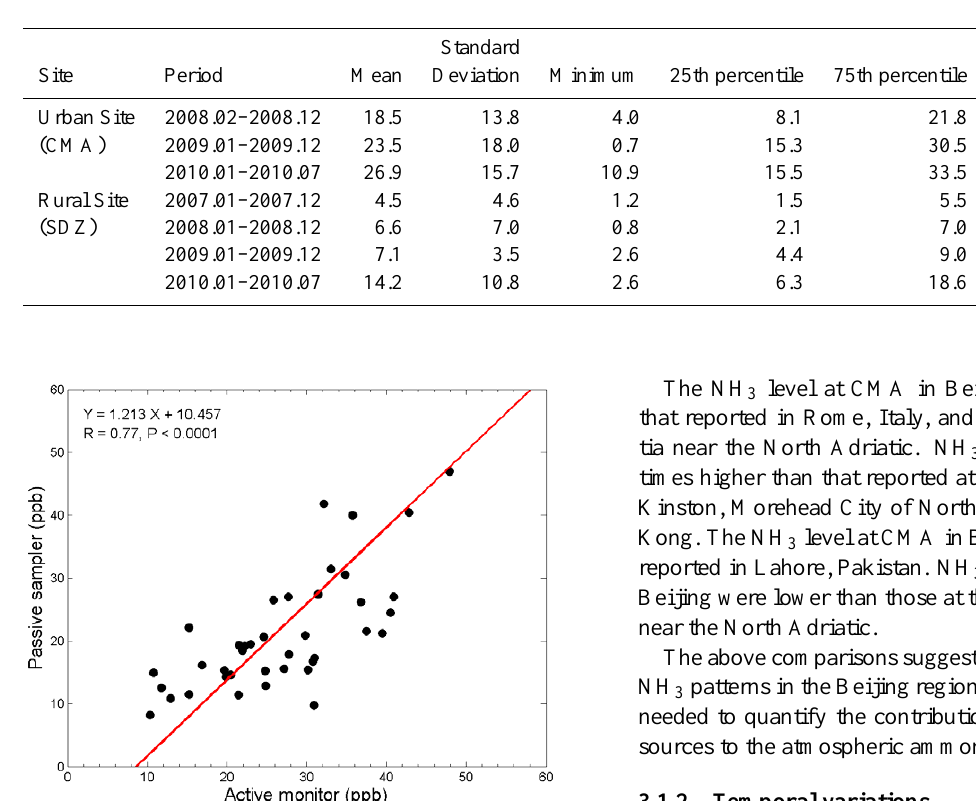
Table 1. Annual summary statistics of weekly and monthly average concentration of NH 3 at urban and rural site in Beijing, in ppb.